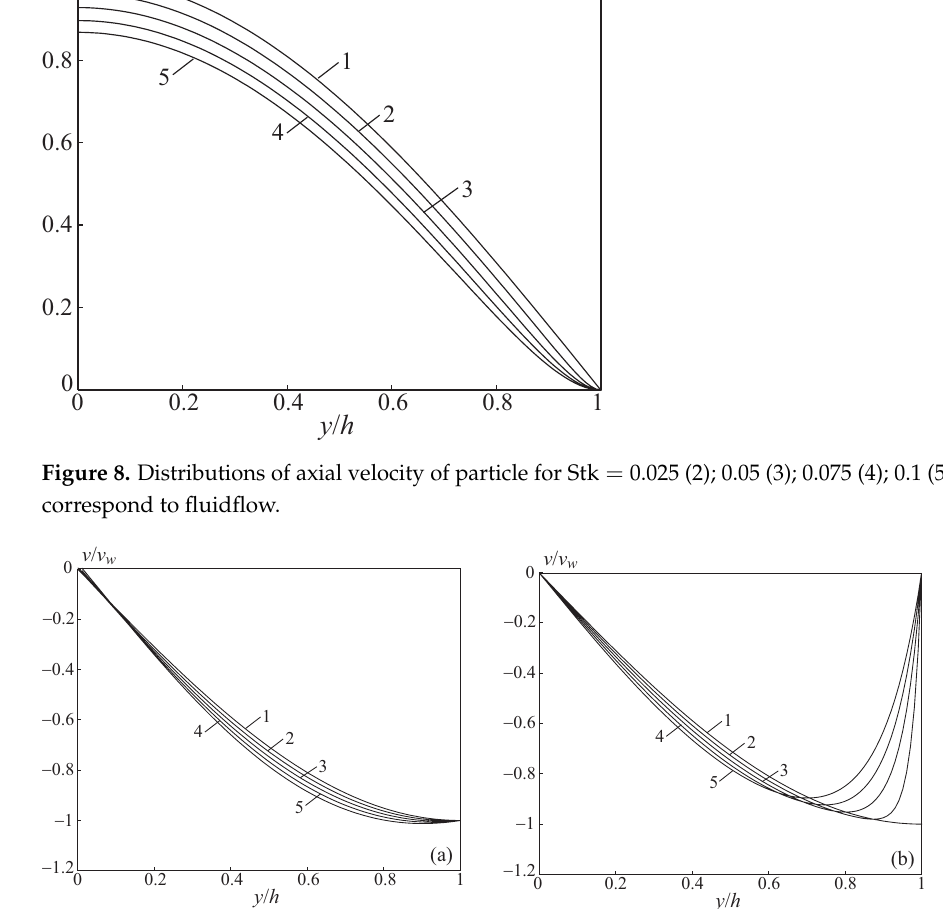
Figure 9. Distributions of radial velocity of particle for φ = 1 ( a ) and φ = 0 ( b ). Lines 2–5 correspond to different Stokes numbers Stk = 0.025 (2); 0.05 (3); 0.075 (4); 0.1 (5). Line 1 correspond to